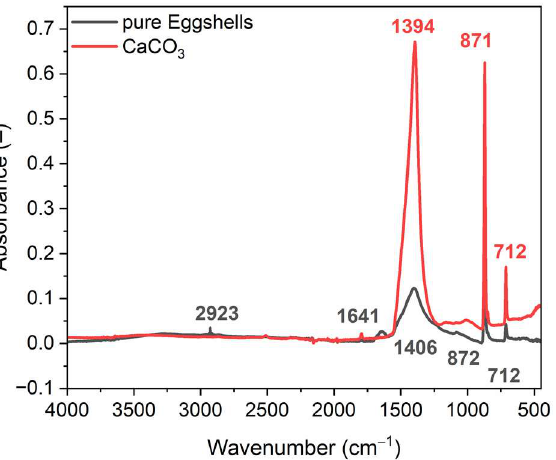
Figure 2. Fourier transform infrared spectroscopy (FITR) spectra for pure ground eggshells and calcium carbonate (CaCO 3 ).